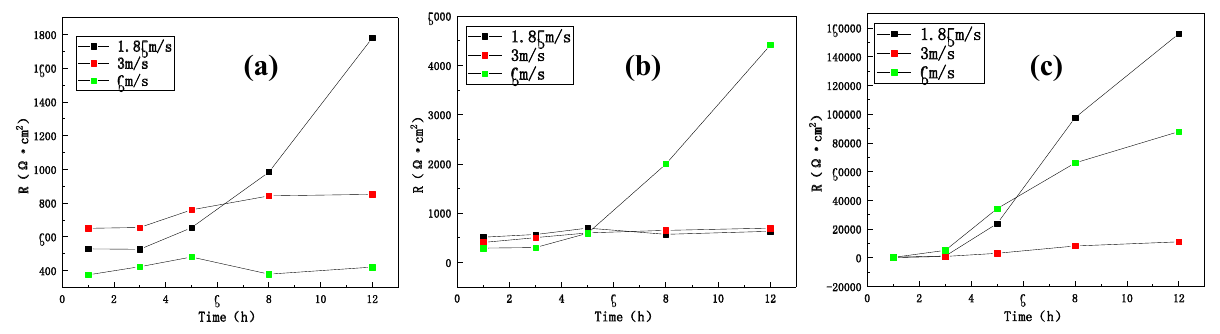
Figure 11. The comparison of total impedance values of three zones of welded joints under different flow rates: ( a ) BM, ( b ) HAZ and ( c )